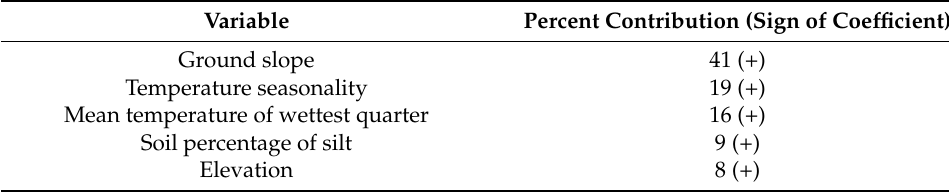
Table A4. Variable contribution and sign of coefficient for the MaxEnt model.